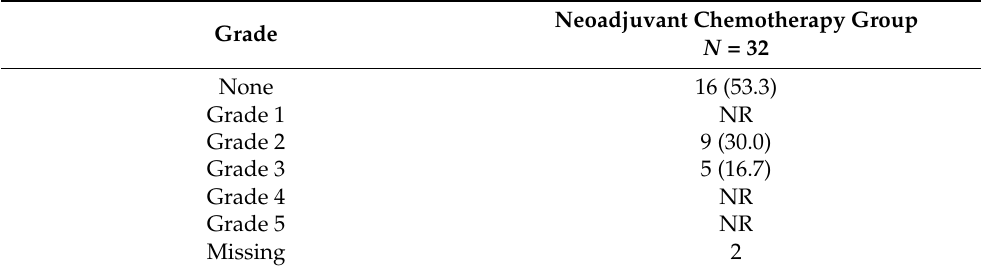
Table 6. Complications of neoadjuvant chemotherapy (CTCAE)